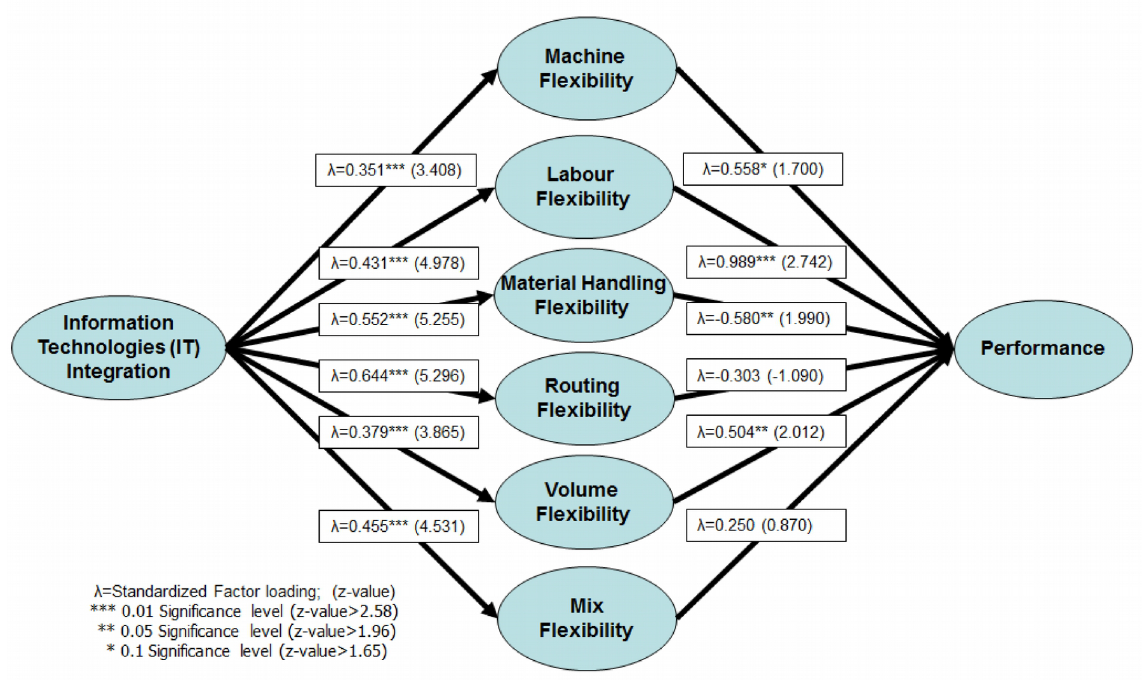
Figure 3. Relationships of the model